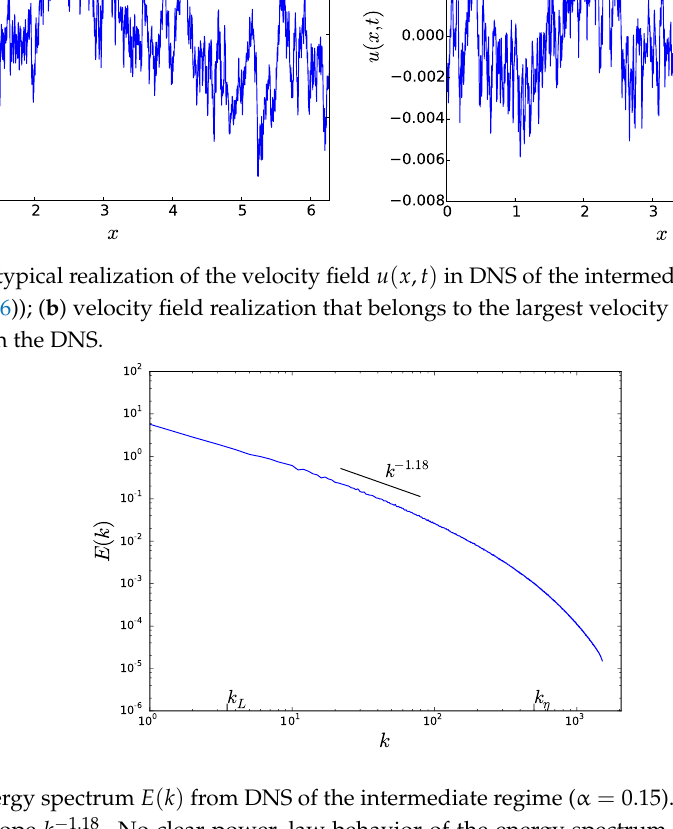
Figure 20. Energy spectrum E ( k ) from DNS of the intermediate regime ( α = 0.15). The line indicates the spectral slope k − 1.18 . No clear power–law behavior of the energy spectrum could be detected. The Kolmogorov spectrum might as well appear for larger k behind the indicated spectral